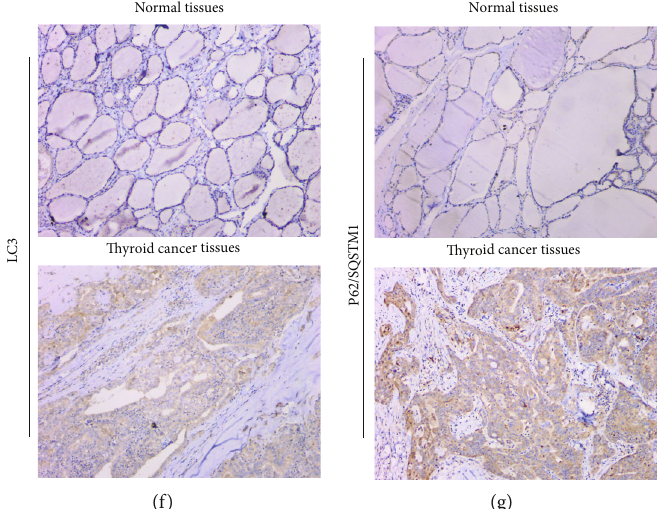
Figure 1: Autophagy was positively correlated with thyroid cancer progression. Gene set enrichment analysis (GSEA) showed that the expression of genes involved in autophagy and lysosome-related biological functions was upregulated in thyroid cancer. (a) GSEA of the data revealed that human thyroid cancer specimens have elevated expression of autophagy-lysosome genes compared with normal thyroid tissue. NES: normalized enrichment score; Nom.: nominal. (b) GSEA showing the correlation between thyroid cancer and the macroautophagy gene signature. (c) Upregulation of macroautophagy genes in thyroid cancer relative to matched normal tissue. (d) GSEA showing the correlation between thyroid cancer and the lysosome gene signature. (e) Upregulation of lysosome genes in thyroid cancer relative to matched normal tissue. (f, g) Immunohistochemistry assays showed an increase in P62/SQSTM1 and LC3 expression in thyroid cancer tissues compared with normal